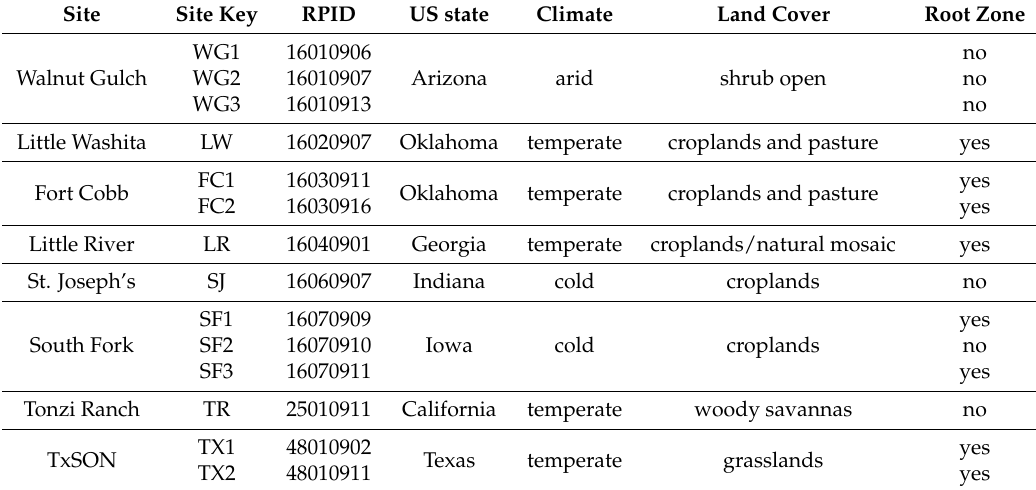
Table 1. Overview of the Soil Moisture Active Passive (SMAP) calibration/validation core sites. Shown are the site name, site key, reference pixel ID (RPID), location, climate, land cover and the availability of root zone measurements (from left to right). The measurement depth for surface soil moisture is 5 cm at all sites. The measurement depth for root zone soil moisture ranges from 30 cm to 75 cm depending on the station